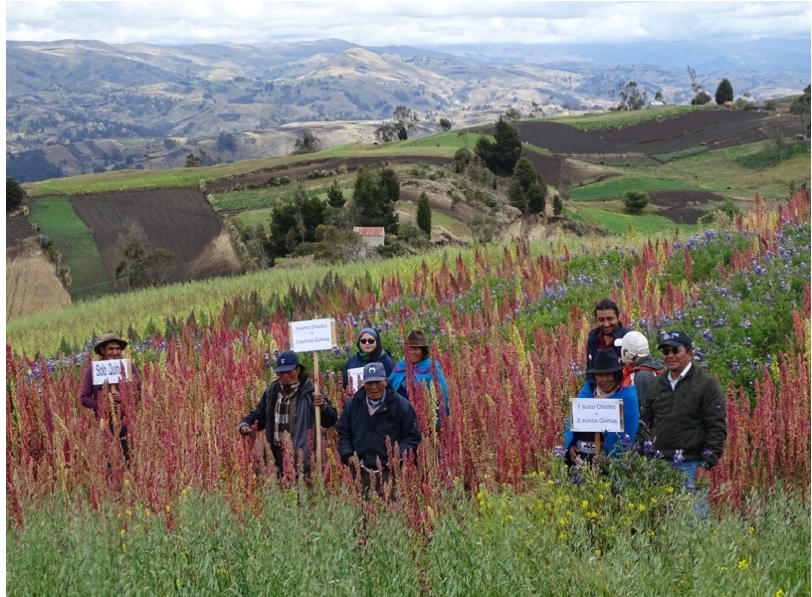
Figure 2. Intercrop system of chocho ( Lupinus mutabilis ) with quinoa. Comunidad Achullay, Guamote. Juan Yuquilema (farmer), Fausto Yumisaca (INIAP Chimborazo), Rodrigo Aucancela, and Galo Morocho (CEFA). Photo: A. Leguizamo.